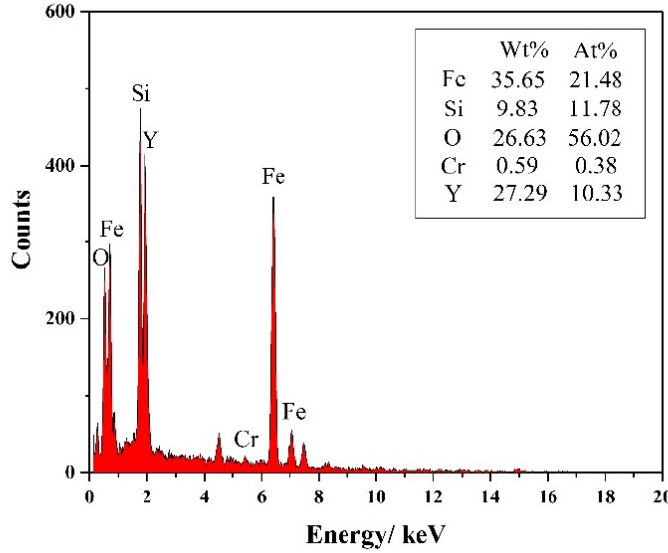
Figure 15. EDS analysis of a second phase in fracture of 1280-S3 ODS steels.